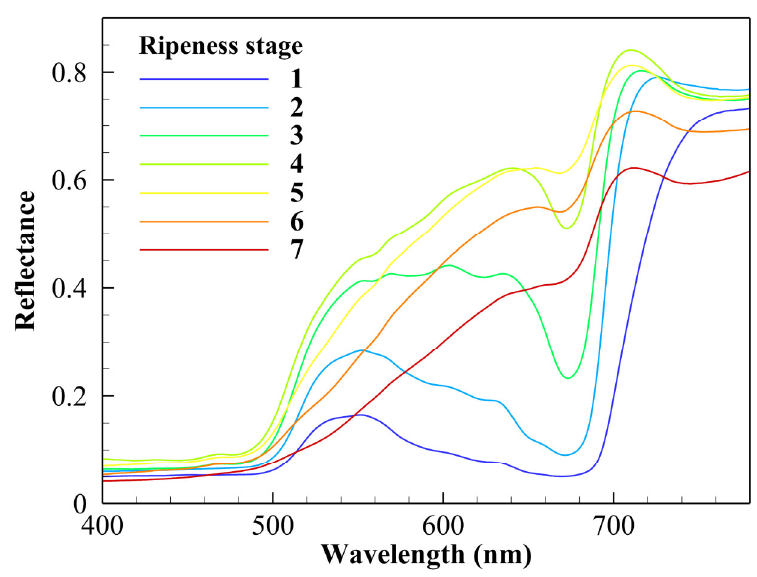
Figure 3. Spectra of 7 ripeness levels.